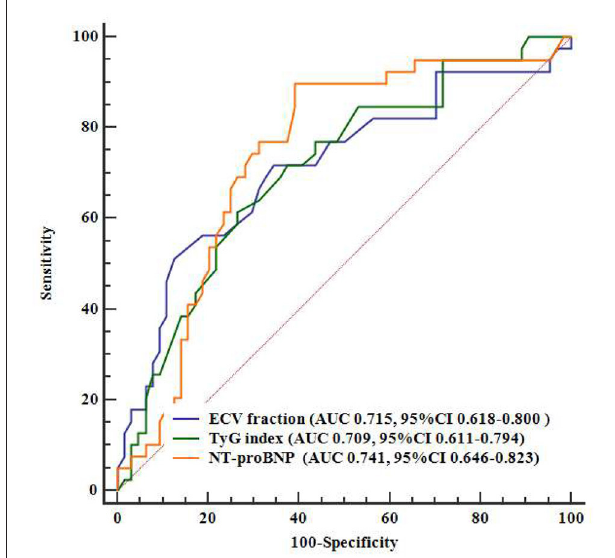
FIGURE 3 | Comparisons between AUCs on ROCs. AUC, area under the curve; ECV, extracellular volume; NT-proBNP, N-terminal pro–B-type natriuretic peptide; ROC, receiver operating characteristics; TyG index, triglyceride–glucose